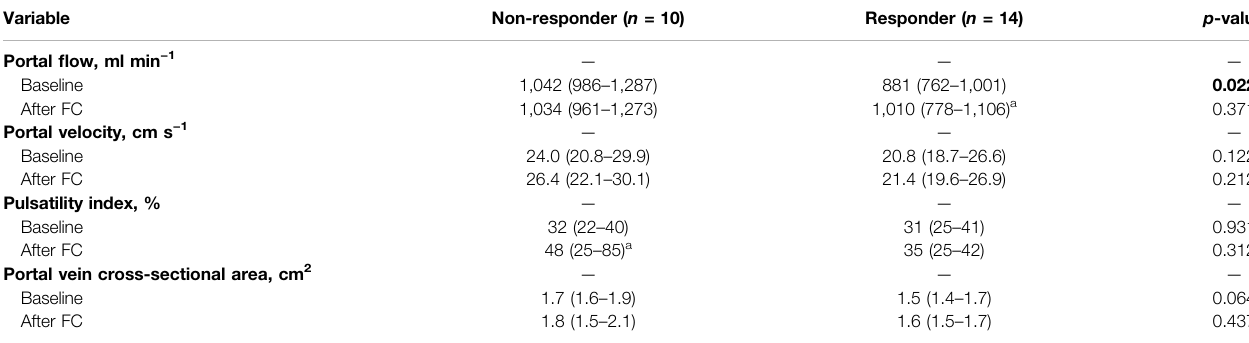
TABLE3| ComparisonsofMRIportalhemodynamicbetweennon-respondersandrespondersafter500 mlof fl uidchallenge.Theboldvaluecorrespondstop-value < 0.05.